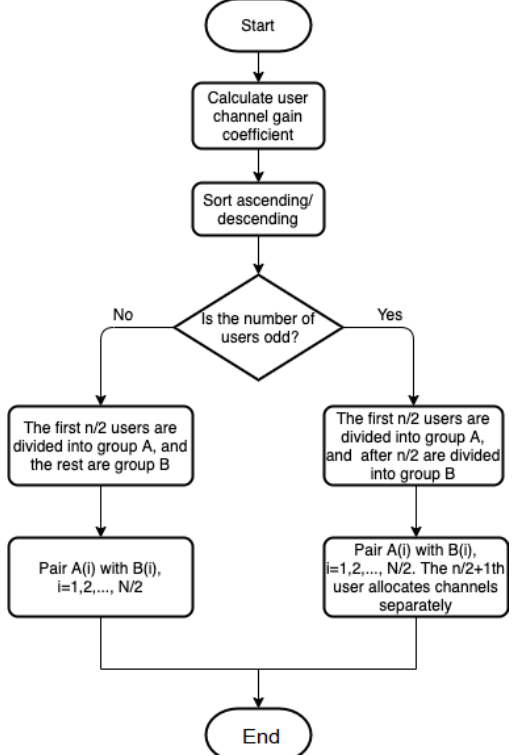
Figure 8. The flowchart of channel state sorting-pairing